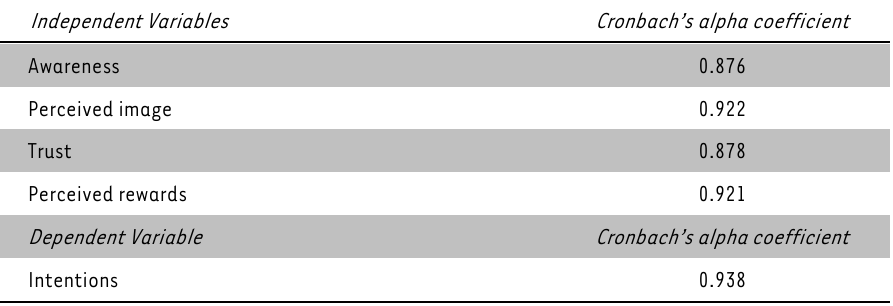
TABLE 3: Cronbach’s alpha